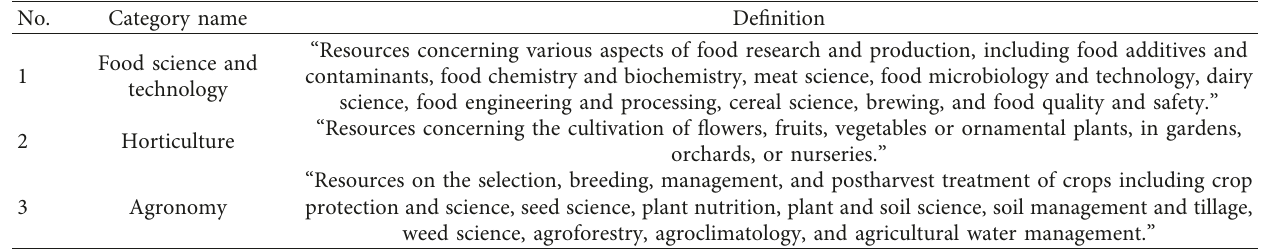
Figure 4: World map showing research collaborations among countries (a) from 2000 to 2006, (b) from 2007 to 2013, and (c) from 2014 to 2020. Brighter blue coloring indicates a higher collaboration rate. Table 4: The categories based on Web of Science (WOS) and expert determinations.